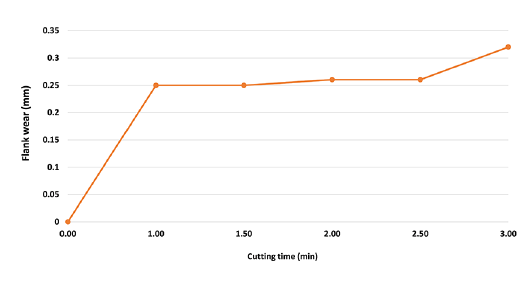
Figure 7. Flank wear in function of cutting time (Vc = 160 /min and f = 0.25 mm/rev)